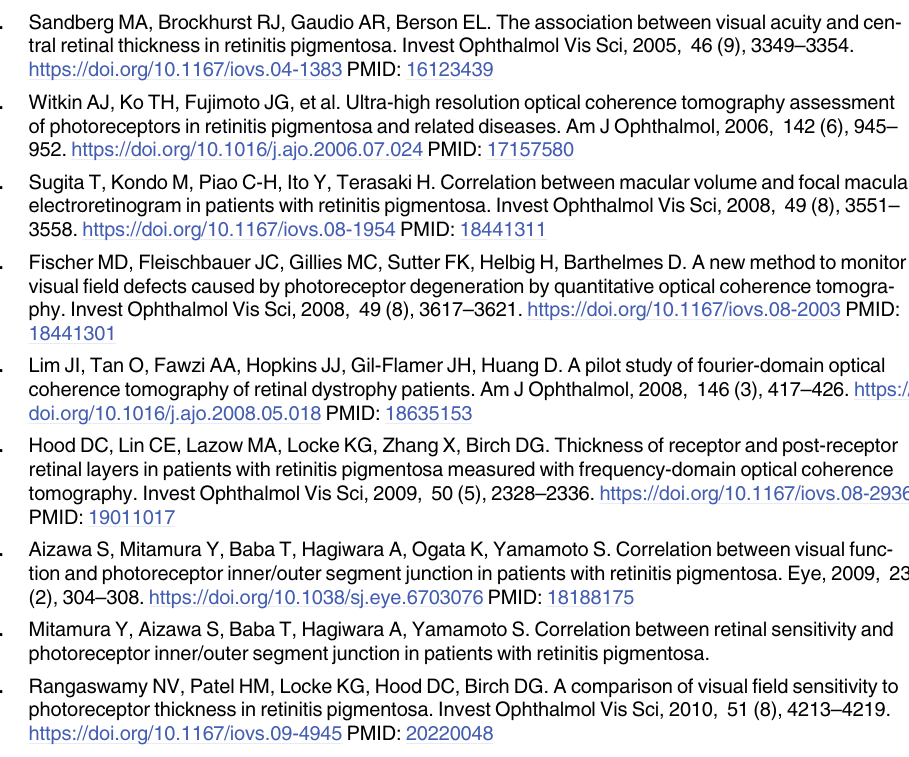
S2 Table. Raw data for the central retinal sensitivity. S3 Table. Raw data for evaluation of the qualitative IS-OS severity grade by the two graders and final